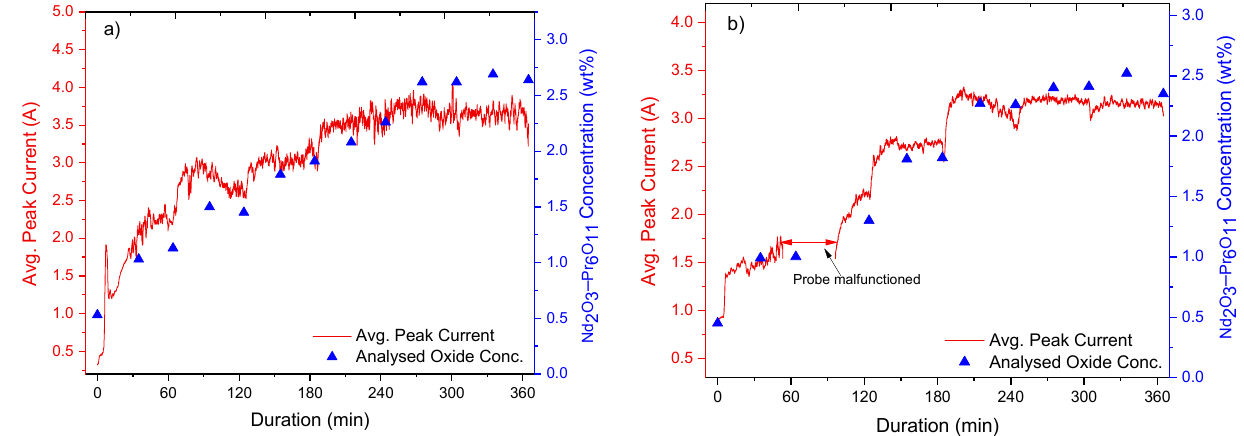
Figure 6. ( a , b ) Data from the dissolution of neodymium and praseodymium oxides (77.5 wt% Nd 2 O 3 –22.5 wt% Pr 6 O 11 ) in a 37.5 mol% NdF 3 –12.5 mol% PrF 3 –50 mol% LiF electrolyte as was done in experiments 8 and 9.